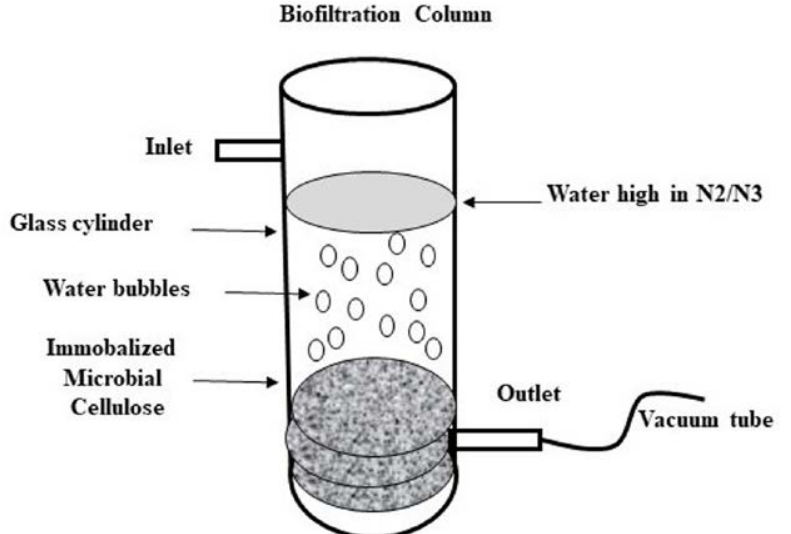
Fig. 1. Biofilter column was built in-house and consists of glass cylinder with a dimension of 90 cmx8 cm with an inlet and outlet points. The bottom of the cylinder is packed with MC sheets that were previously co-incubated with Pseudomonas aeruginosa to be immobalized on the MC